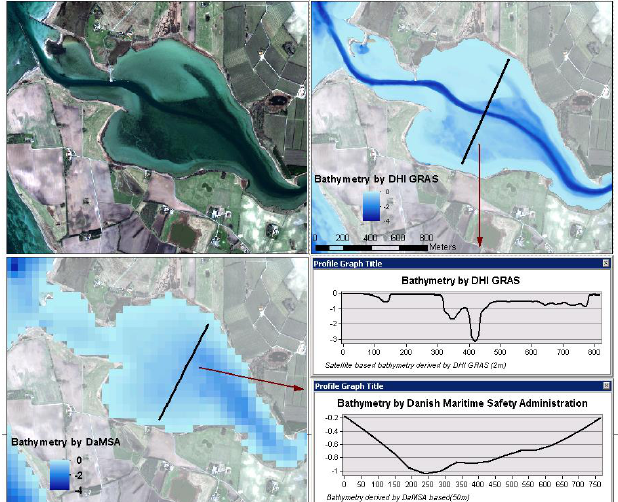
Figure 6. Example of WorldView-2 based derived bathymetry for a shallow water Fjord in